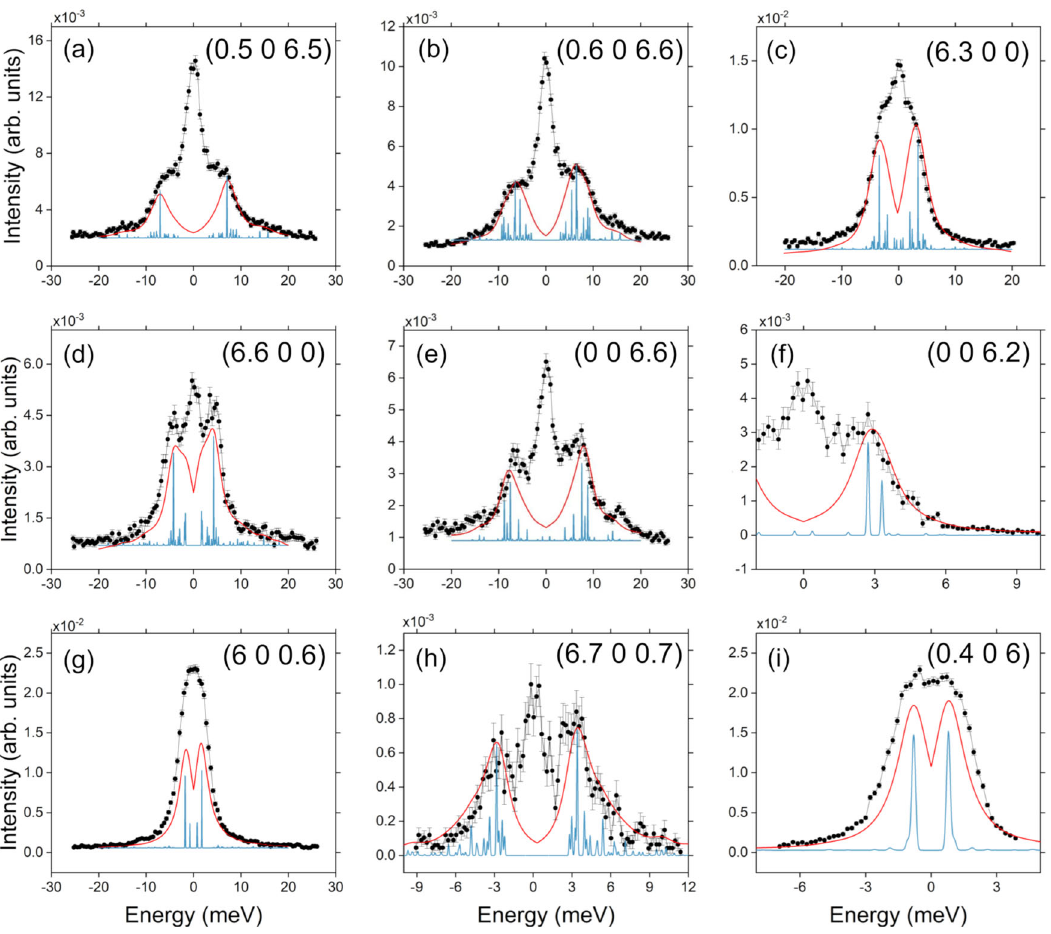
Fig. 3 | Phononic excitations intensities: ID28 vs simulations. ID28 data (black scatters, with error barsrepresenting the SE)) along different symmetry directions andQvaluescomparedwiththesimulatedcross-section(redlines)calculatedwith